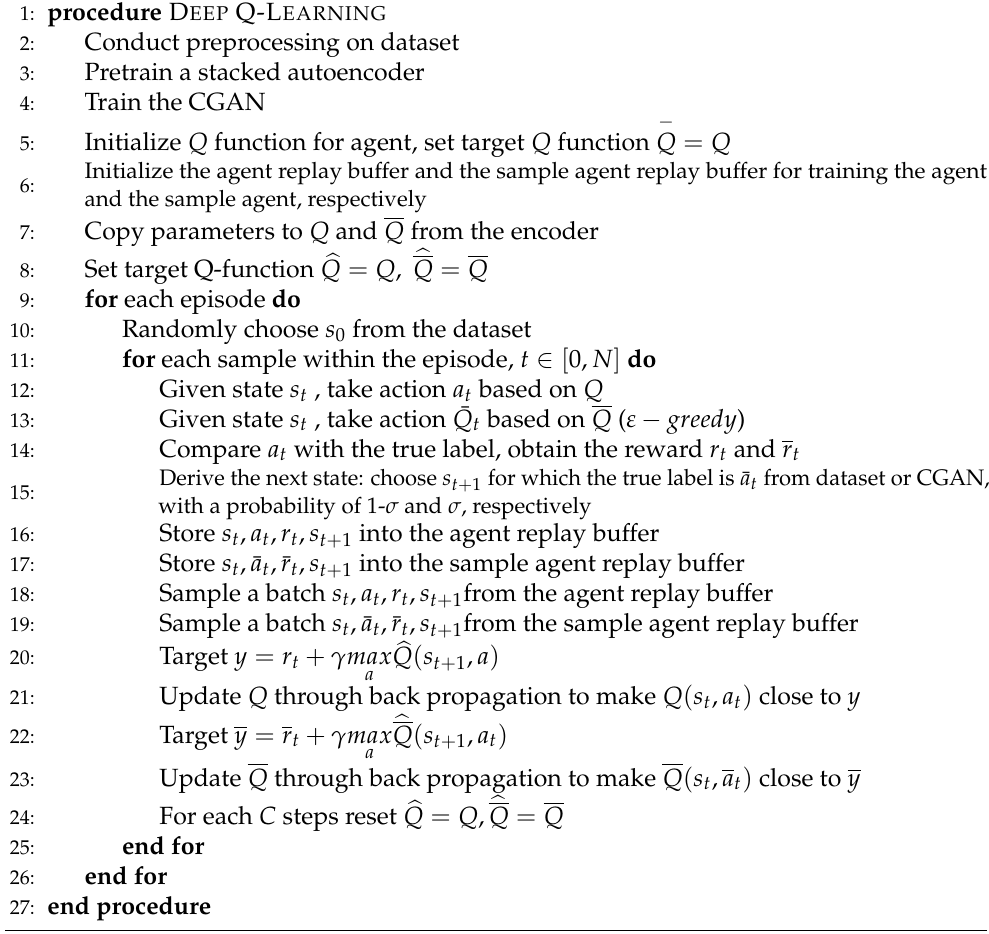
Algorithm 3 Deep Q-Learning Framework for Detection at